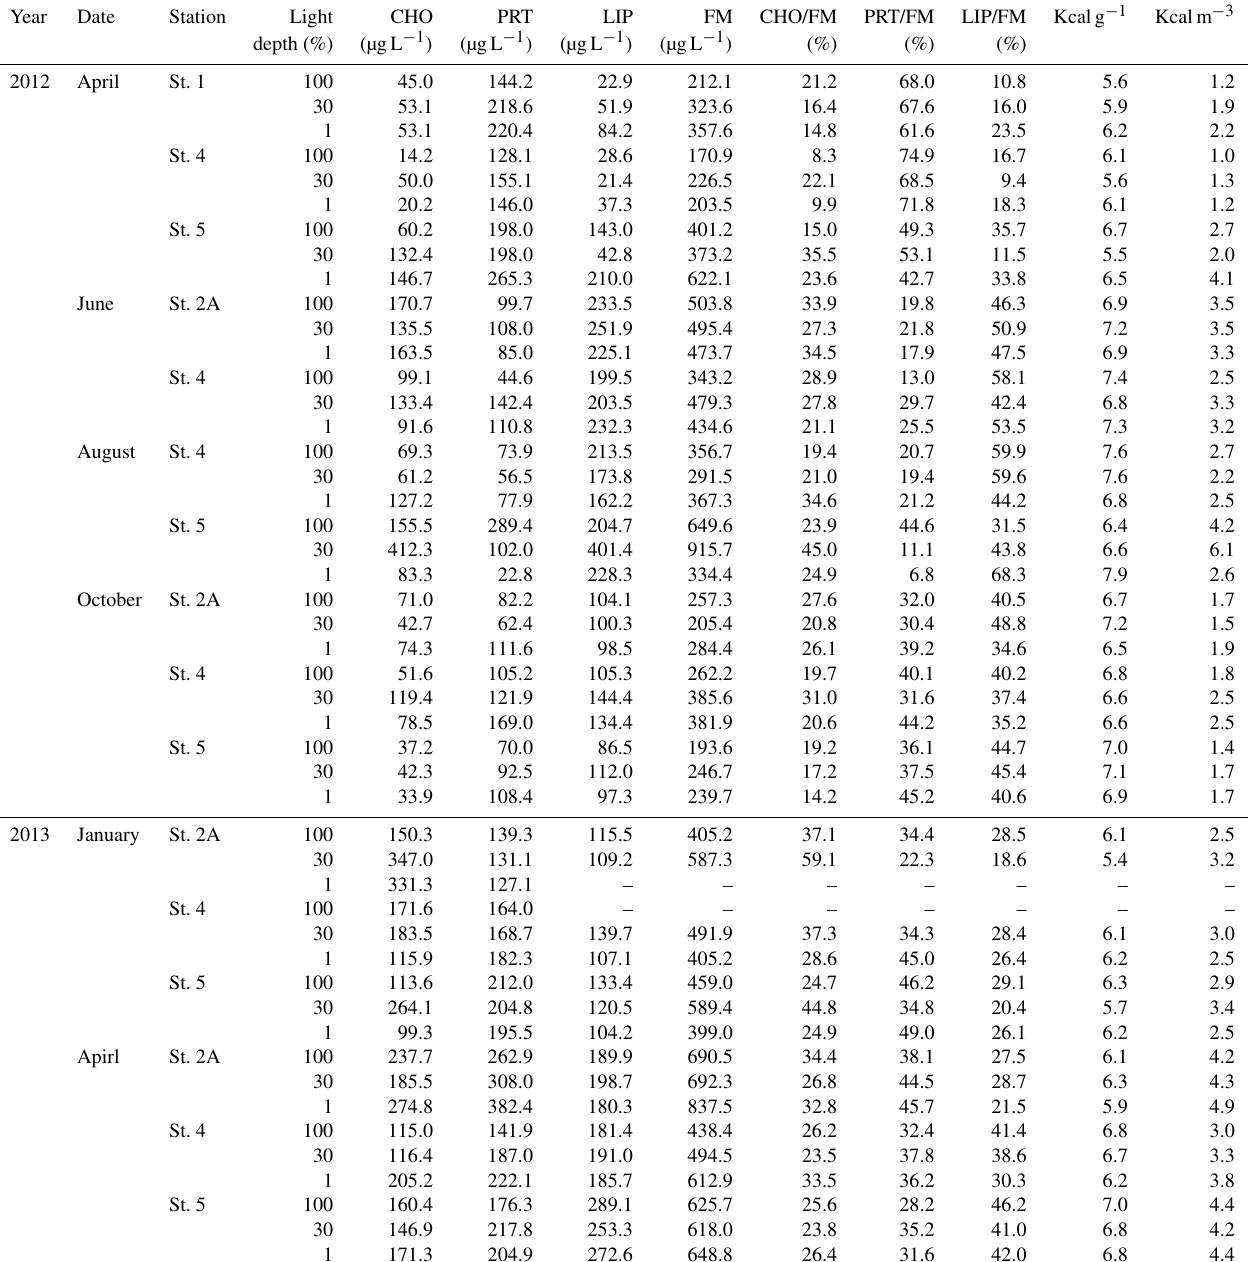
Table 5. The biochemical concentrations, composition, calorific values, and contents in Gwangyang Bay (“–” indicates no data). Year